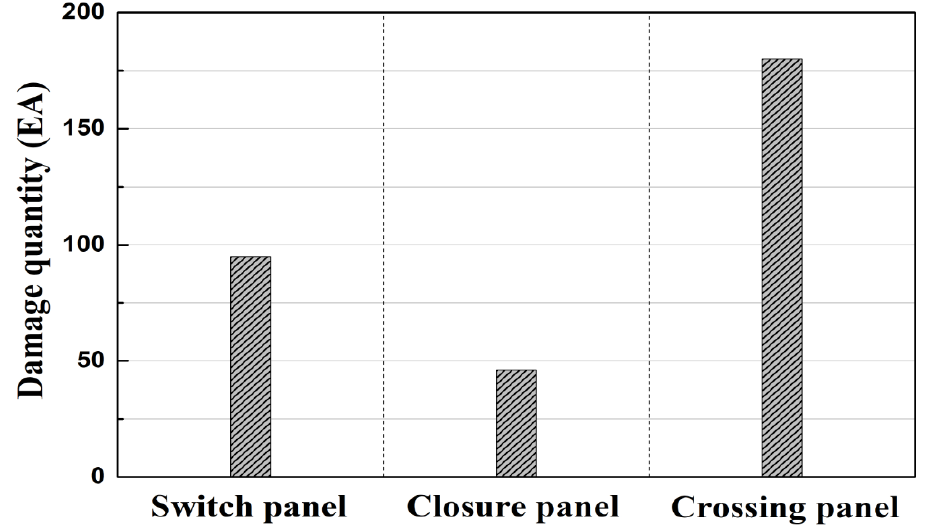
Figure 9. Overview of damage status for main positions in the railway.